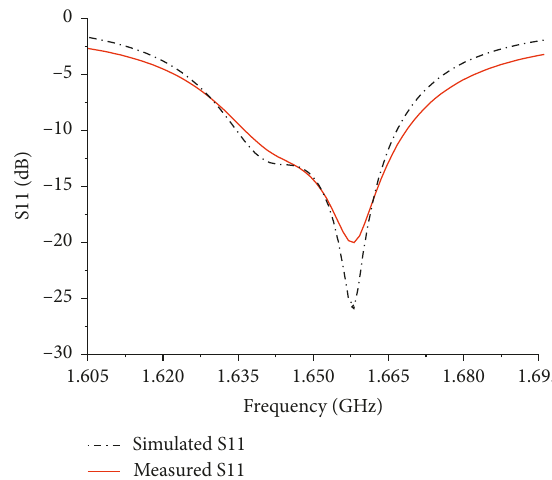
Figure 13: The simulated and measured S11 of the proposed CP microstrip antenna.